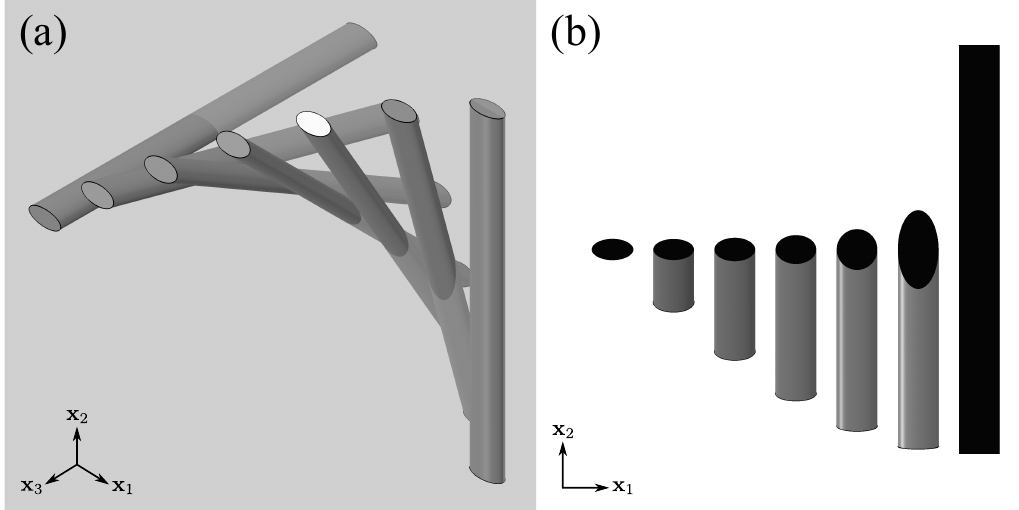
Figure 2. Elliptical fibers varying between θ = 0 ◦ (left) and θ = 90 ◦ (right): ( a ) 3D view; and ( b ) cross-section in a viewing